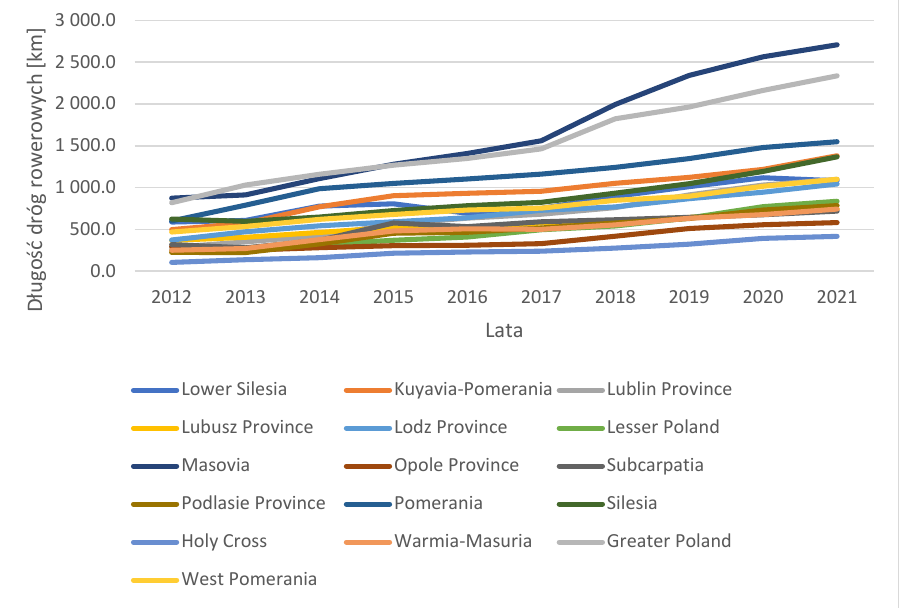
Figure 3. Change in the length of bicycle roads in Poland in years 2011–2021 by province. Source: Author own